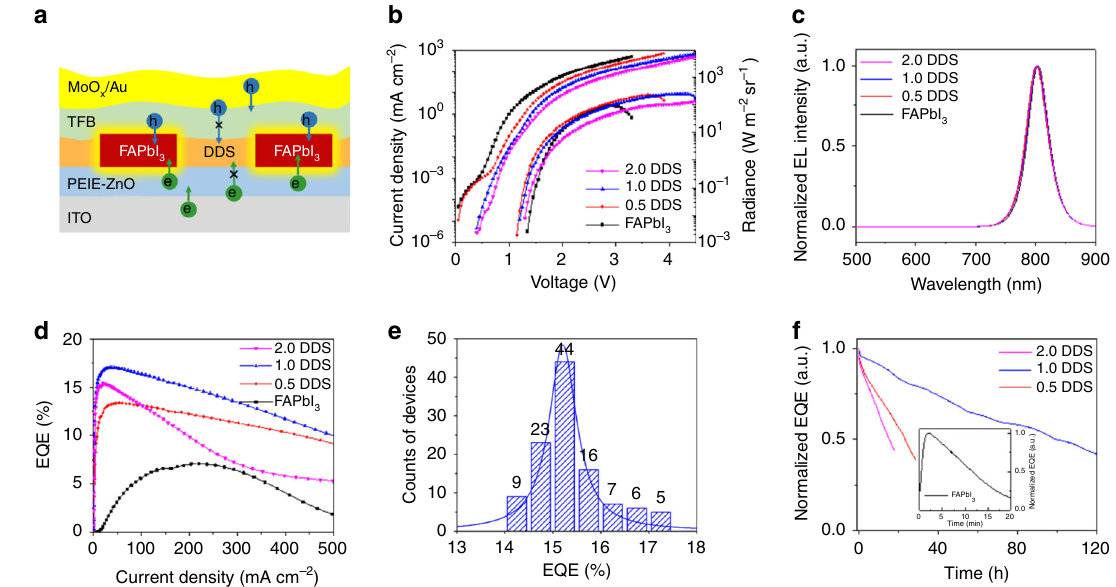
Fig. 4 Characteristics of PMC thin fi lm-based LEDs. a Schematic illustration of the PMC thin fi lm-based LEDs. b Current density-voltage-radiance curves of LEDs. c Normalized EL spectra of LEDs at 2.0 V driving voltage. d EQE-current density curves of the LEDs. e Histogram of peak EQEs of 110 LEDs based on the 1.0 DDS fi lms. f Operational stability of PMC thin fi lms-based LEDs (instet: FAPbI 3 -based LED) at a constant current density of 20 mA cm − 2